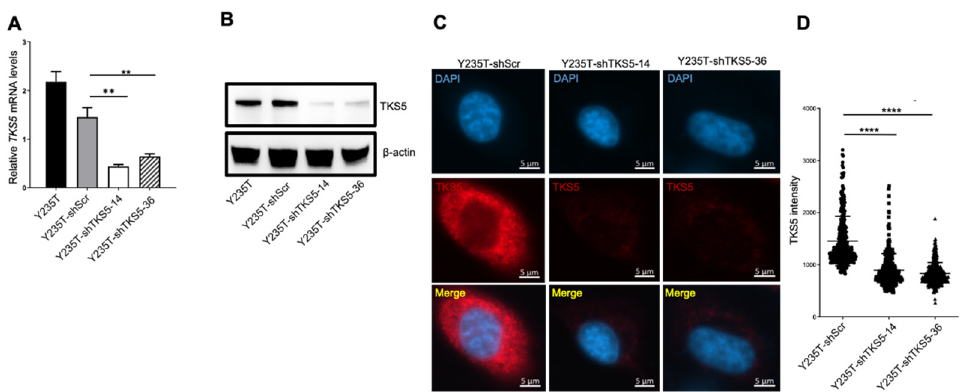
Figure 3. Knockdown of TKS5 in Y235T cells. ( A ) Relative TKS5 mRNA levels in Y235T parental, scramble control (shScr), shTKS5-14 and shTKS5-36 cells from RT-qPCR experiment. ( B ) Determination of TKS5 protein levels by Western blot in Y235T parental, scramble control (shScr), shTKS5-14 and shTKS5-36 cells. ( C ) Representative immunostaining images showing reduced TKS5 signal intensities in Y235T cells with the specific shRNAs. Blue indicates DAPI, and red indicates TKS5. ( D ) Quantitation of TKS5 signal intensity as detected by immunocytochemistry in Figure 3C. We repeated the qPCR and Western blot experiments three times. We used Student’s t -test and analysis of variance (ANOVA) to analyse the statistical significance. Error bar represents mean +/ − SD (** p < 0.001; **** p < 0.0001).